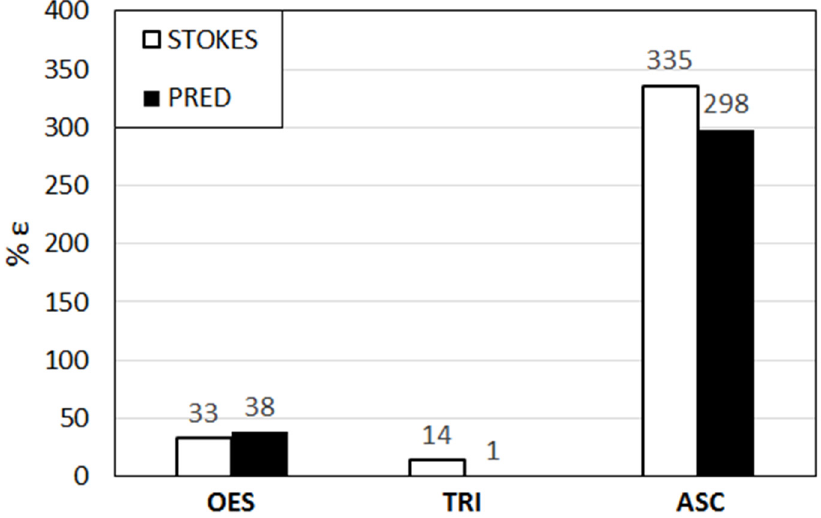
Figure 14. Percentage errors (% ε ) in calculation of sink velocity, according to the present predictions (PRED) and based on the Stokes law (STOKES). Errors are calculated with respect to the experimental values.